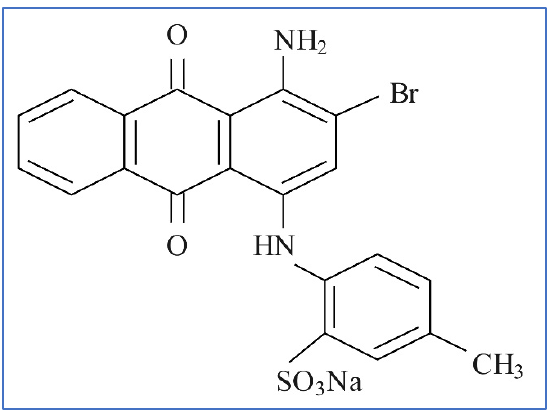
Figure 9. Structure of the acid blue 78 dye.